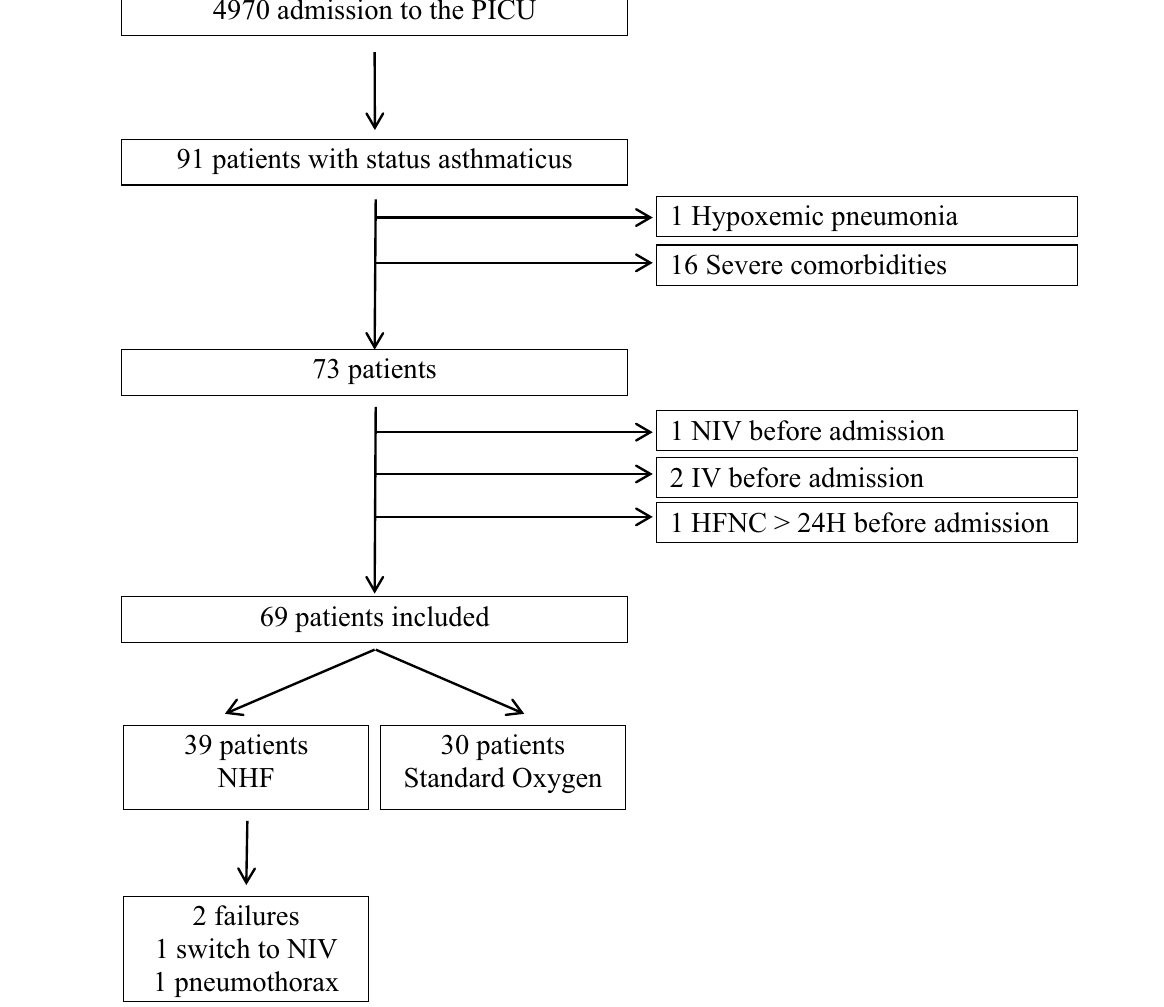
Fig. 1 Patient flow chart. PICU paediatric intensive care unit, NHF nasal high flow, NIV non-invasive ventilation, IV invasive